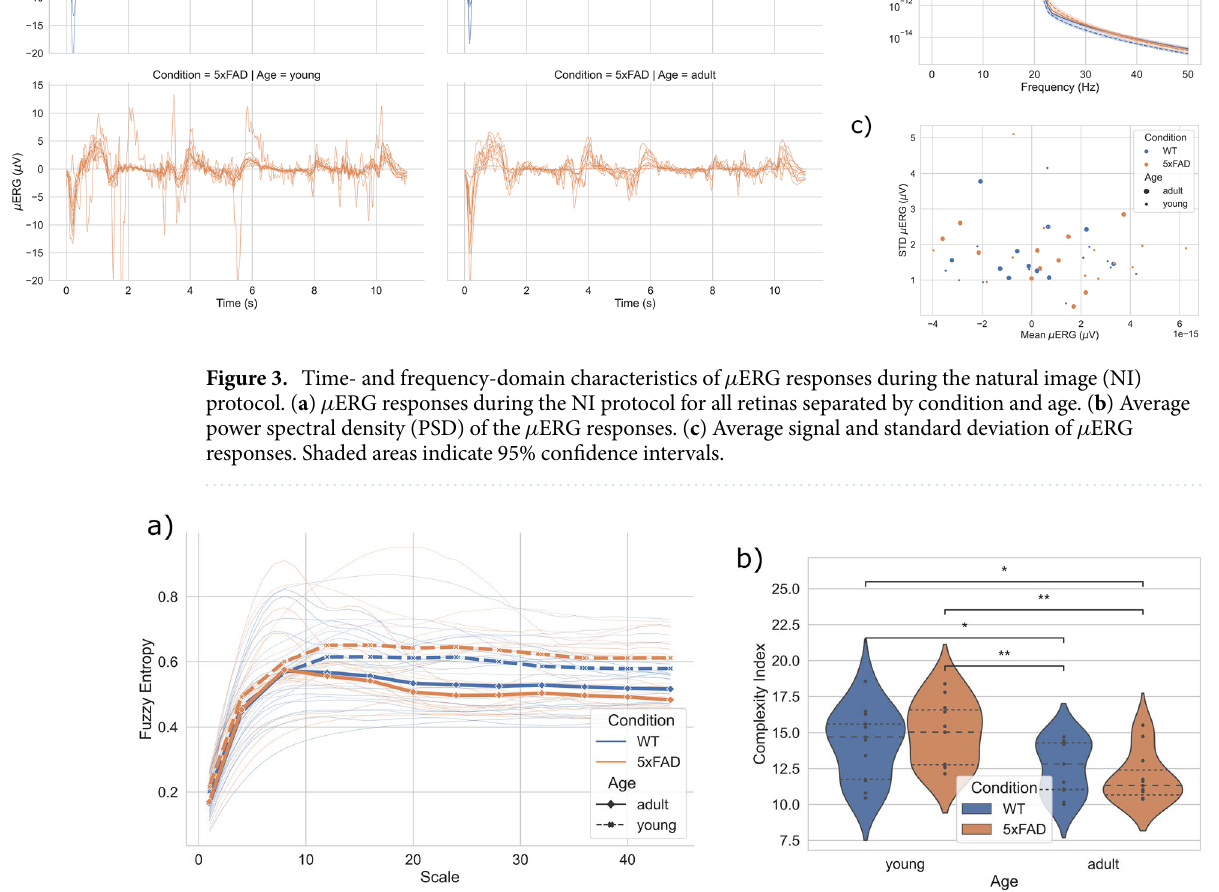
Figure 4. Multiscale entropy (MSE) analysis of µ ERG in response to a deterministic stimulus. ( a ) MSE curves of µ ERG responses for the chirp stimulus (CS) protocol. Thinner lines: MSE curves of all retinas; thicker lines: average MSE for groups WT-young, WT-adult, 5xFAD-young and 5xFAD-adult. ( b ) Complexity index, calculated as area under the MSE curve. Dashed lines: first, second ( i.e. , median) and third quartiles. *: p < 0.05 and **: p < 0.01 for Mann–Whitney U